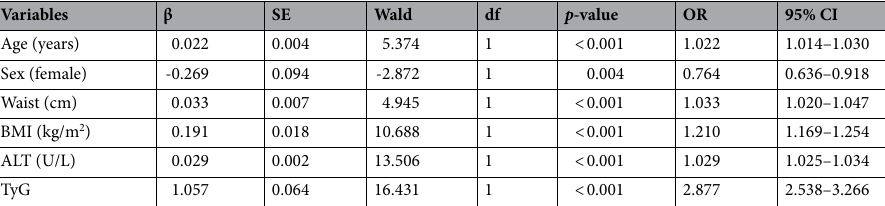
Table 2. Multivariate logistic regression analysis for risk factors of NAFLD. BMI body mass index, ALT alanine aminotransferase, TyG triglycerides and glucose index, OR odds ratio, NAFLD nonalcoholic fatty liver disease.